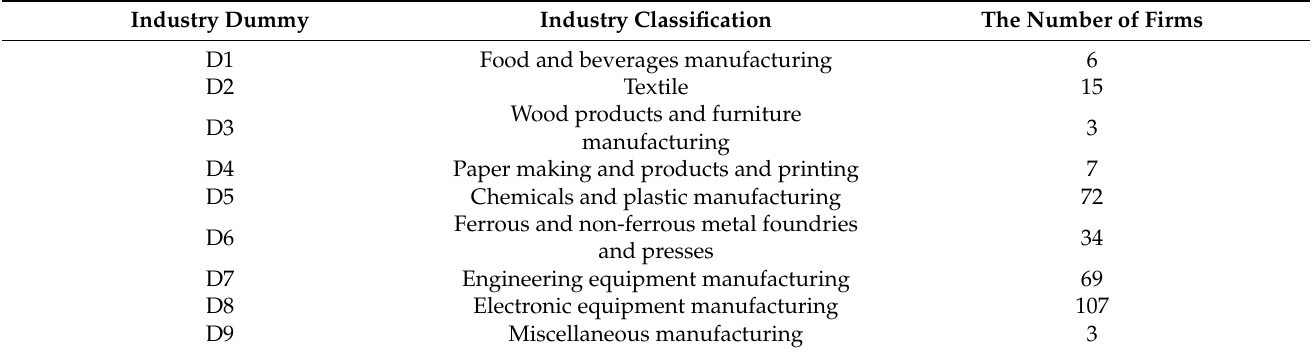
Table A1. The classification of manufacturing